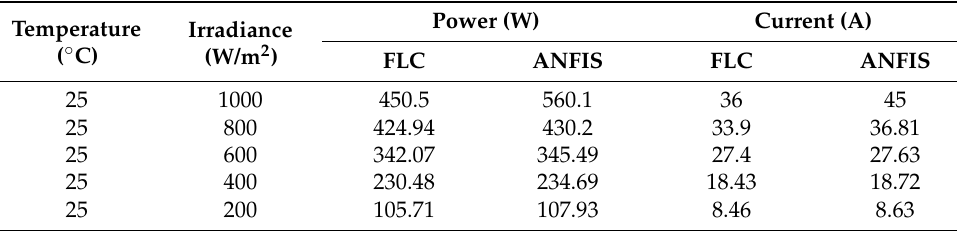
Table 11. Solar power output (ANFIS vs. FLC) at 12.5 V of EV’s electrical